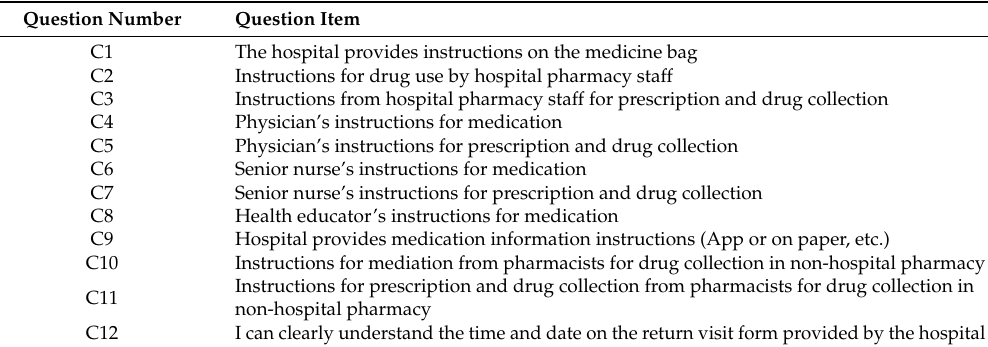
Table 14. Satisfaction with medical service